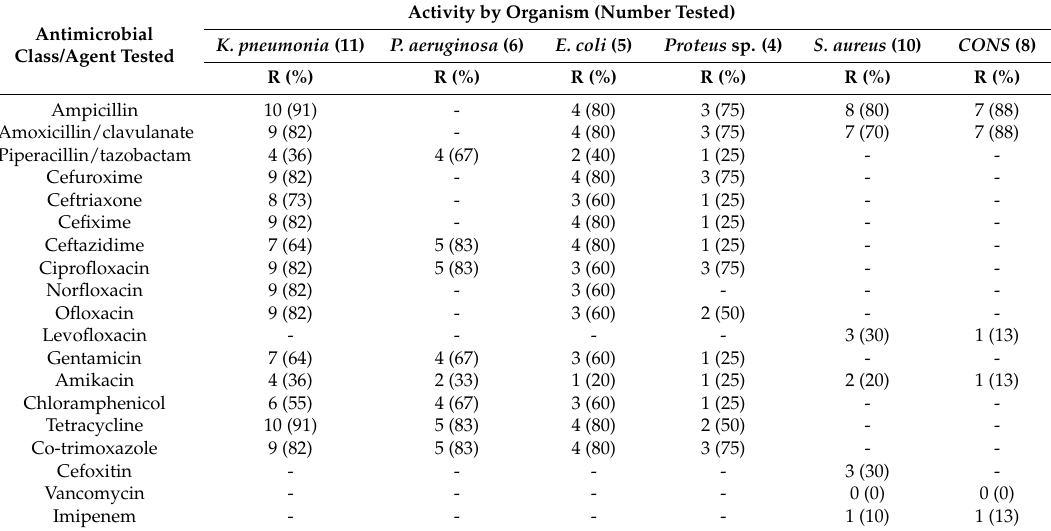
Table 2. The antibiotic-resistance-pattern of the most prevalent causes of laboratory-confirmed blood stream infections in a cohort of 150 neonates. Activity by Organism (Number Tested) Antimicrobial K. pneumonia (11) P. aeruginosa Class/Agent Tested